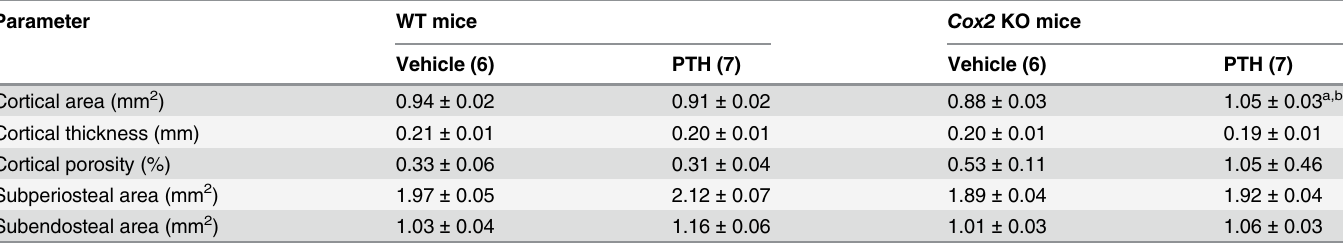
Subendosteal area (mm 2 ) Data are means ± SEM for (n) mice.